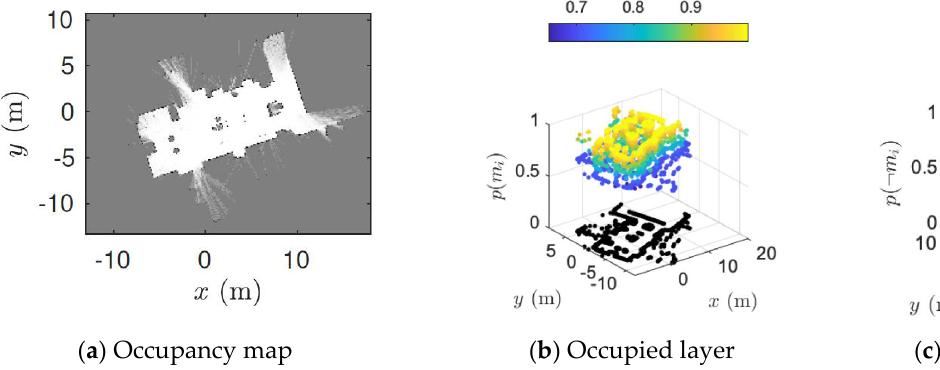
Figure 6. An example of probabilistic grid map alongside the position of occupied and obstacle-free cells with their respective spatial probabilities.